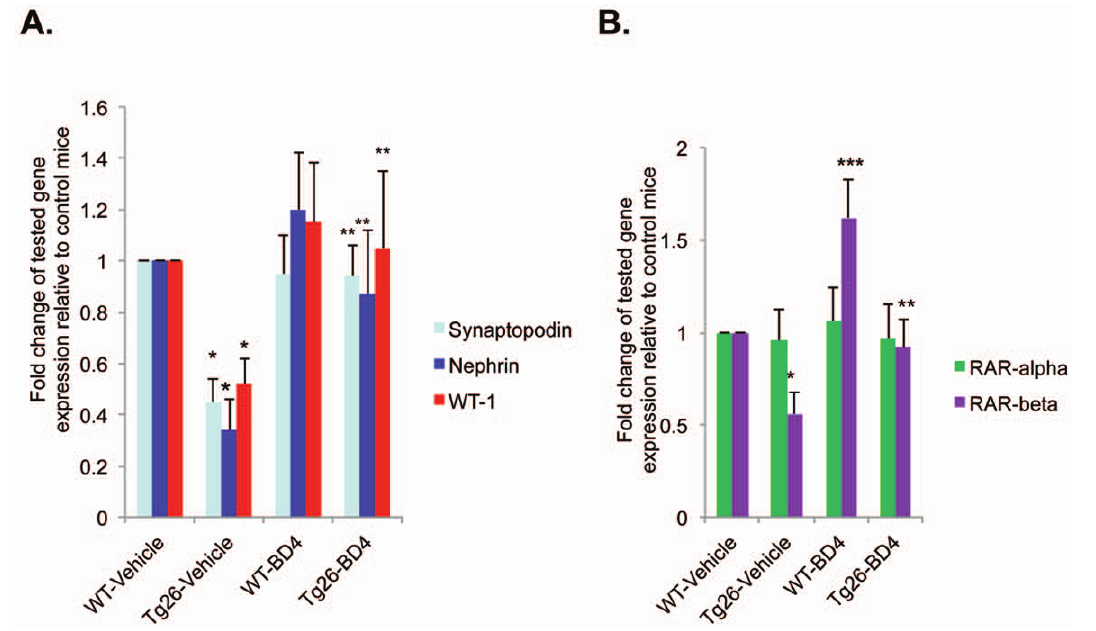
Figure 7. Expression of podocyte differentiation markers in vivo. Glomeruli were isolated from both WT and Tg26 mice treated with vehicle or BD4 for 6 weeks. Total RNA was isolated from the glomeruli for real-time PCR analysis for the podocyte differentiation markers including synaptopodin, nephrin, and WT-1 ( A ) as well as for RAR a and RAR b ( B ). The ratio of these genes normalized to GAPDH was calculated. n=6, *p , 0.01 compared to vehicle-treated WT mice (WT-vehicle), **p , 0.05 compared to vehicle-treated Tg26 mice (Tg26-vehicle), ***p , 0.05 compared to vehicle- treated WT mice (WT-vehicle).